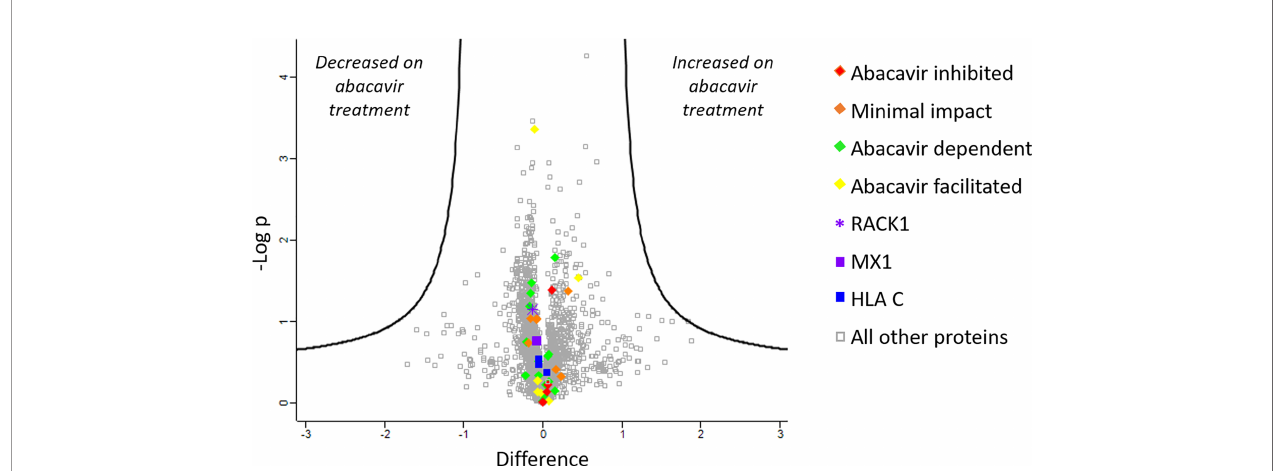
FIGURE 2 | Abacavir does not perturb the proteome of C1R.B*57:01. Comparison of protein abundance between untreated and abacavir treated (48 h, 35 µM) C1R.B*57:01 cells (three replicates per treatment) revealed no major perturbation of the cellular proteome. The volcano plot depicts the difference (log 2 FC) vs -Logp of 2,306 proteins between untreated and treated conditions. A 5% FDR and a slope of 1 were used as the cut-off for signi fi cance (thick black line). No proteins were signi fi cantly perturbed by abacavir treatment; furthermore identi fi ed source proteins for the HLA ligands analysed clustered close to 0 on the difference axis. Source proteins for HLA ligands from the different subsets analysed are shown as indicated in the key. The purple asterisk shows RACK1, the source protein of peptides KTIKLWNTL (abacavir facilitated), and YTDNLVRVW (minimal impact), and the purple square shows MX1, the source of peptides LTSELITHI (abacavir dependent) and KVVDVVRNL (abacavir inhibited). All other proteins are shown by grey